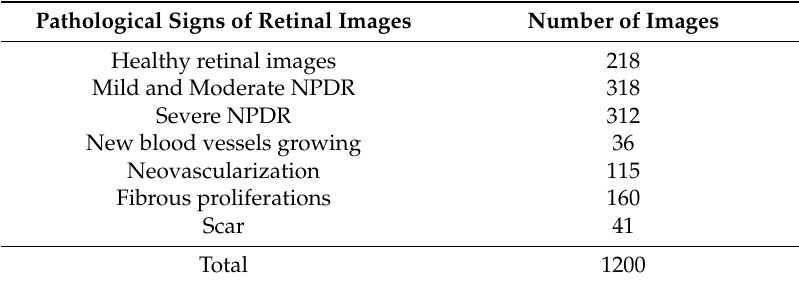
Table 2. Number of each pathological signs of retinal images.